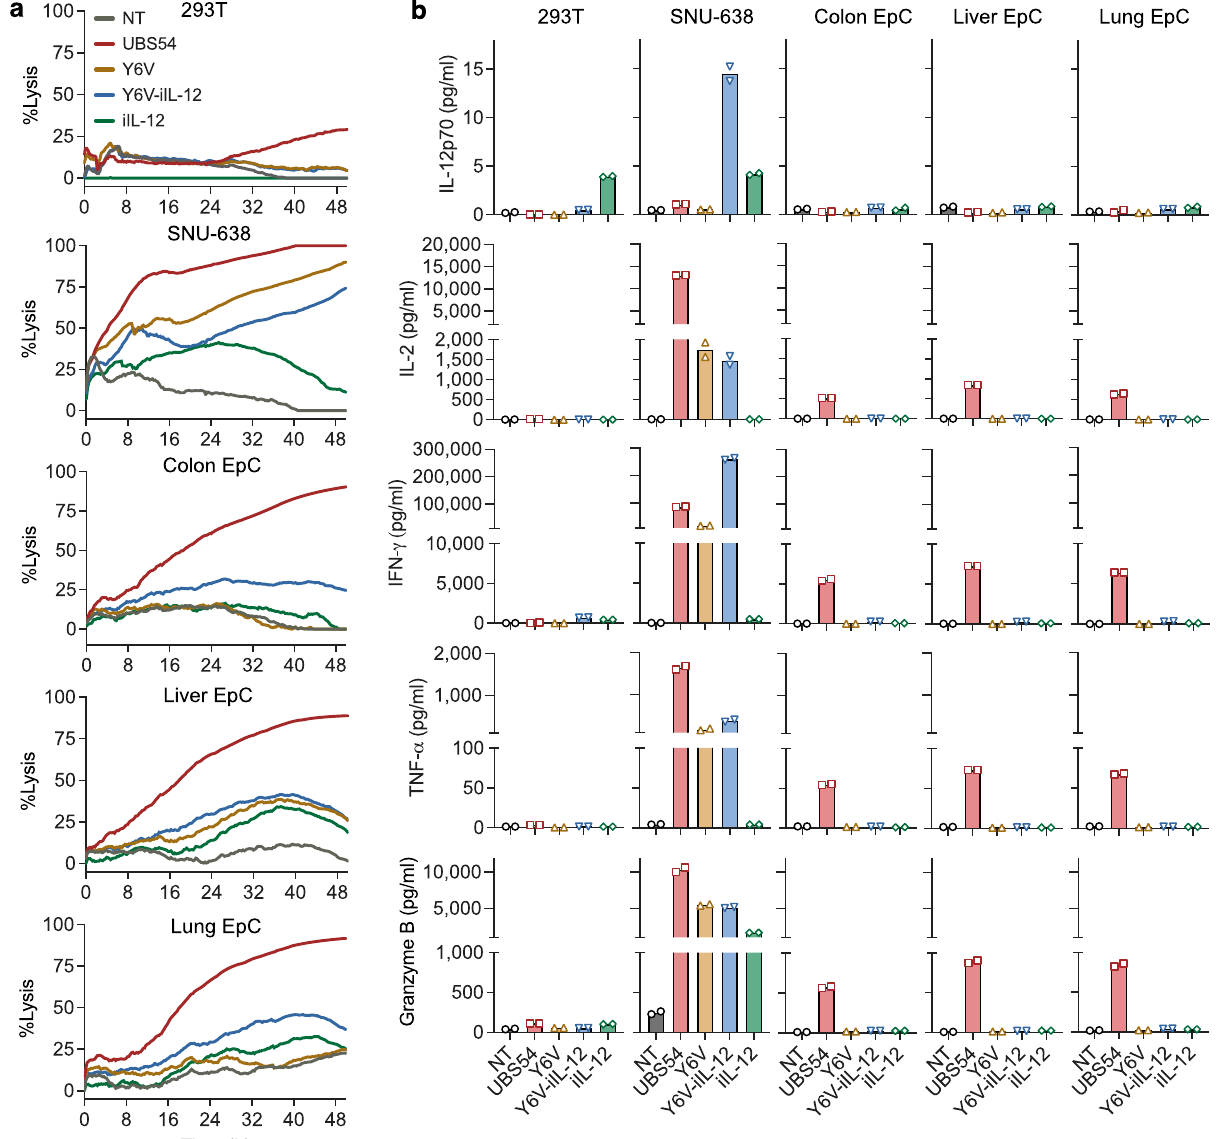
Fig. 4 | Inducible IL-12 armored af fi nity-tuned CAR T cells maintain the ability to discriminate tumors overexpressing EpCAM from primary epithelial cells. a Impedance-based cytotoxicity assay measuring cytolytic activity of CAR-T cells against primary epithelial cells (EpC), using 293T and SNU-638 as negative and